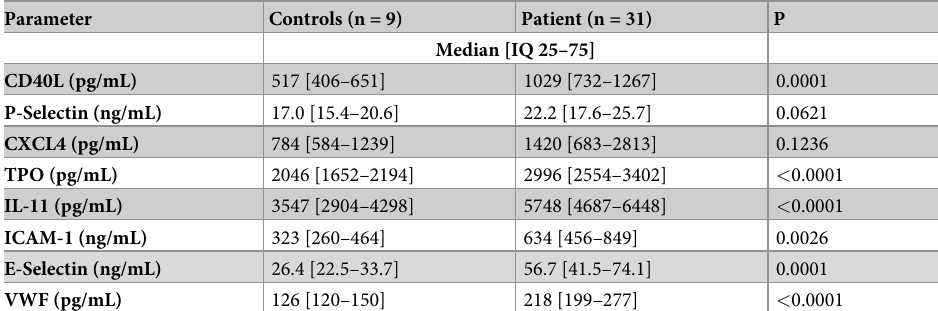
Table 1. Plasma levels of markers of platelet activation and